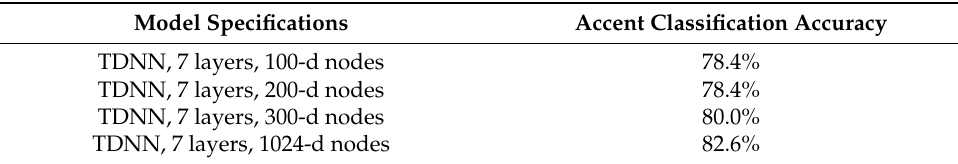
Table 1. Accent classification accuracy of a standalone network.